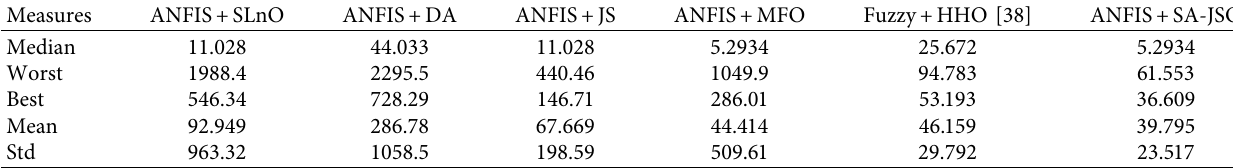
Table 5: Statistical analysis for adopted model over existing models for group 1 scenario.